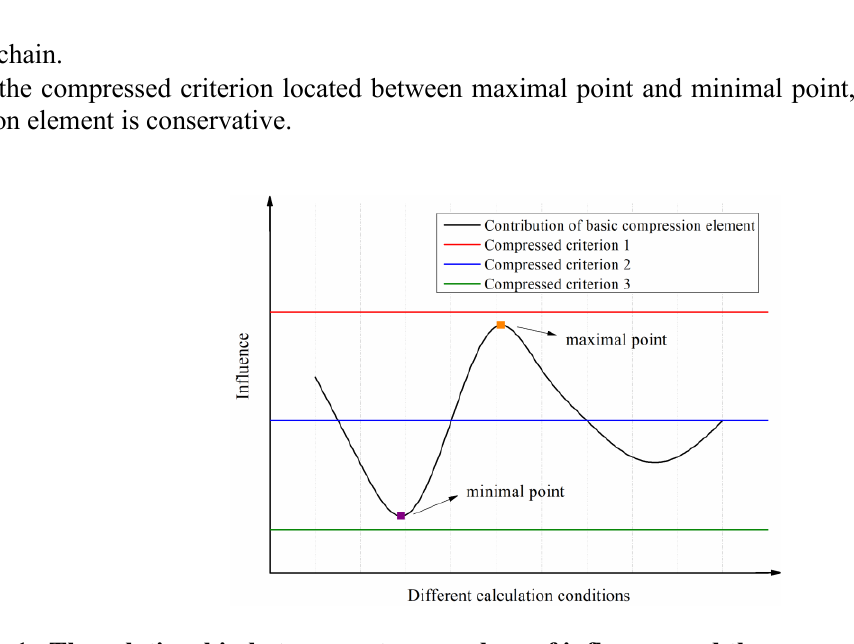
Figure 1. The relationship between extreme values of influence and the compressed criteria If the microscopic reaction rate of a neutron-induced reaction is large enough, this neutron-induced reaction channel is important and all decay reactions are relatively unimportant. In reverse,